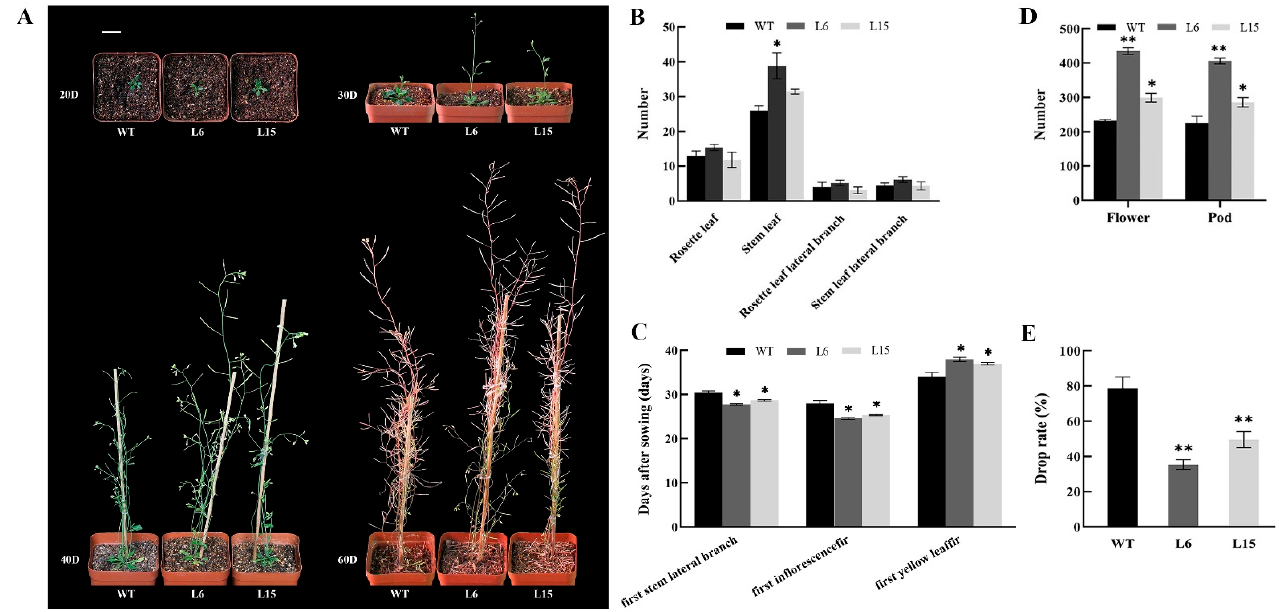
Figure 6. Morphological phenotype analysis of CpSRG1 transgenic plants. ( A ) CpSRG1 transgenic Arabidopsis at different stages under normal growth condition. The pictures were taken 20, 30, 40 and 60 days after sowing. Bar denotes 2 cm. ( B ) Number of leaf and branch. ( C ) The day of the first stem collateral branch, the first inflorescence and the first yellow leaf. ( D ) Number of flower and silique. ( E ) Drop rate. WT (wild-type plants, Col-0); L6 & L5, transgenic plants overexpressed CpSRG1 . Data represent mean of three biological repeats ± SEM. Error bars indicate the standard error of mean. Asterisks denote statistically significant differences compared with control, * p < 0.05, ** p < 0.01.